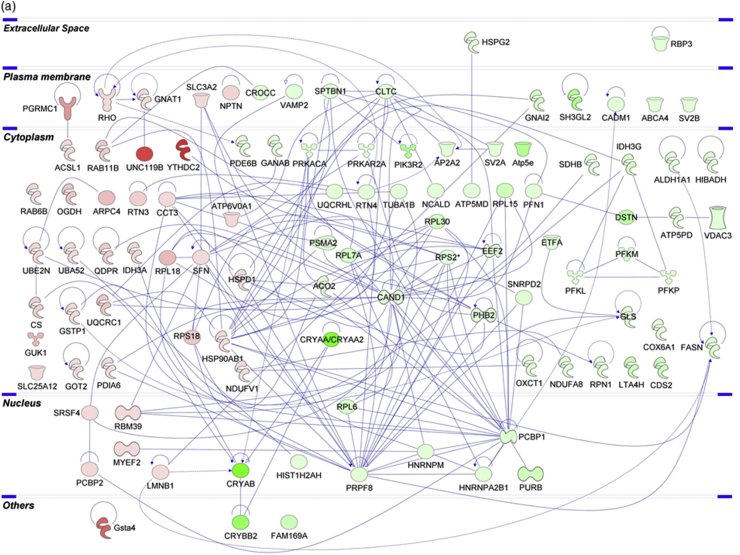
Protein-protein interaction (PPI) networks of the differentially expressed proteins of ocular vascular beds. The PPI generated by IPA analysis depicts the networks of differentially expressed proteins in the (a) ophthalmic artery and (b) retina. Colours red and green represent increment and decrement of protein abundance, respectively; with different colour intensities that correspond to the degree of differential expression. Proteins are annotated according to their cellular localization and are depicted as different shapes, which represent the functional classes of the proteins (e.g. enzyme, transporter, ion channel, etc.). (For interpretation of the references to colour in this figure legend, the reader is referred to the Web version of this article.)